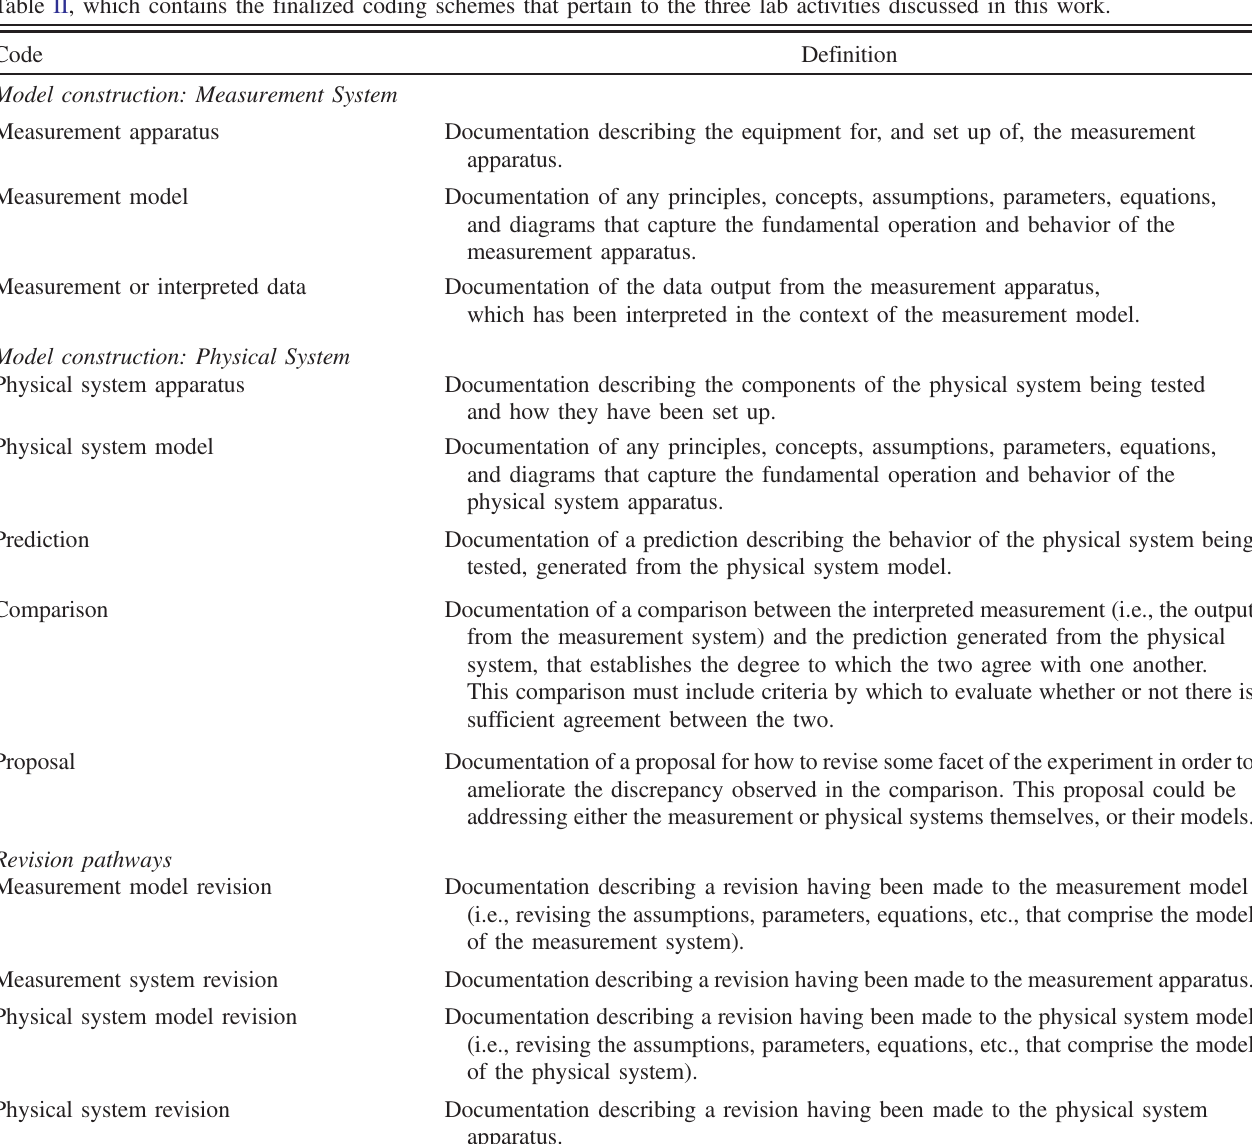
TABLE I. Generalized codes that capture all the components of the modeling framework (Fig. 1). This generalized coding scheme can be tailored to the modeling that is contained in specific lab activities — any particular lab activity is not likely to contain all components present in the table and those that are present will required updated definitions that capture the specifics of how that modeling step manifests in the lab activity. Some lab activities might require multiple instances of each of these codes if the lab activity has students performing multiple iterative modeling cycles. For an example of this coding scheme that has been tailored to specific lab activities, see Table II, which contains the finalized coding schemes that pertain to the three lab activities discussed in this